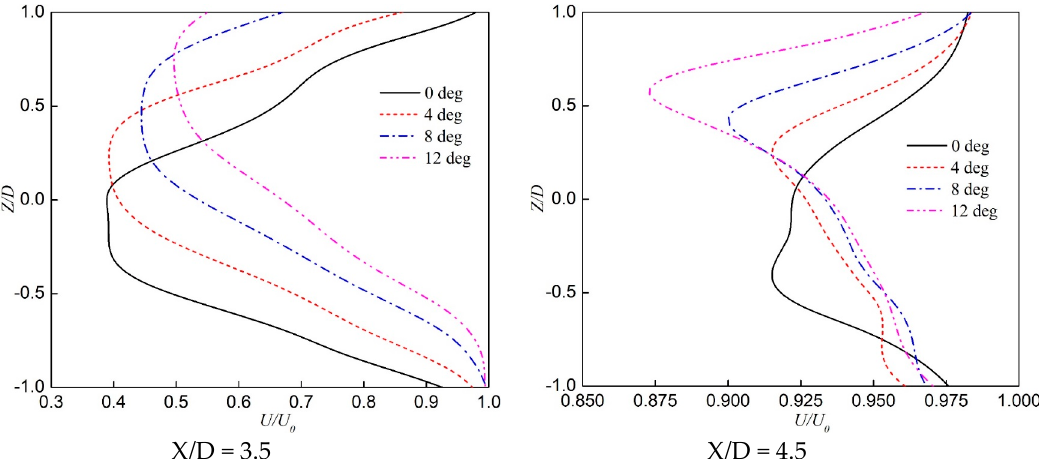
Figure 22. The distribution of instantaneous axial velocity along blade span at the wind turbine downstream positions of 0.5D, 2.5D, 3.5D and 4.5D.